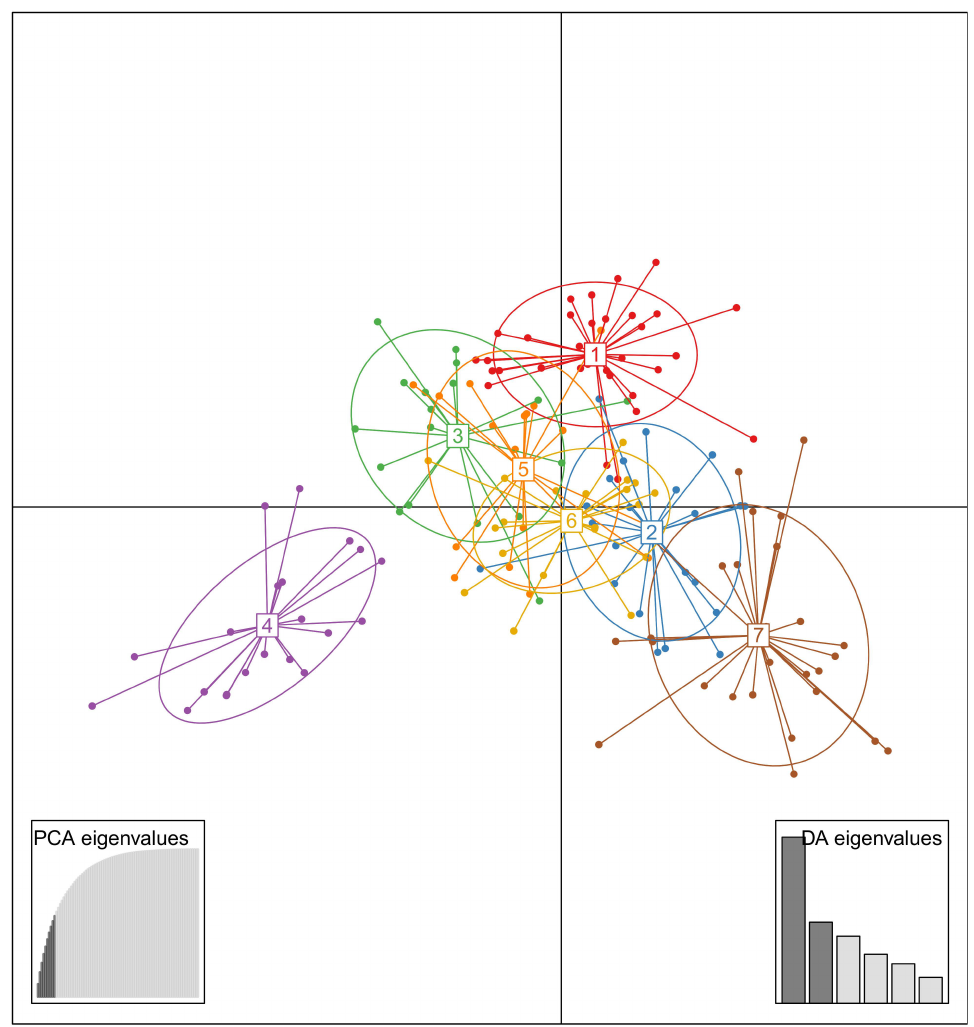
Figure 2. Scatterplot of DAPC of population structure of 161 Japanese plum-type accessions, showing the first two principal linear discriminants of the DAPC according to the optimal K value ( K = 7). Each colored circle represents a group: G1 = red, G2 = blue, G3 = green, G4 = purple, G5 = orange, G6 = yellow, and G7 = brown. Each dot represents an accession. The insets represent the eigenvalues of the Principal Component Analysis (PCA) and Discriminant Analysis